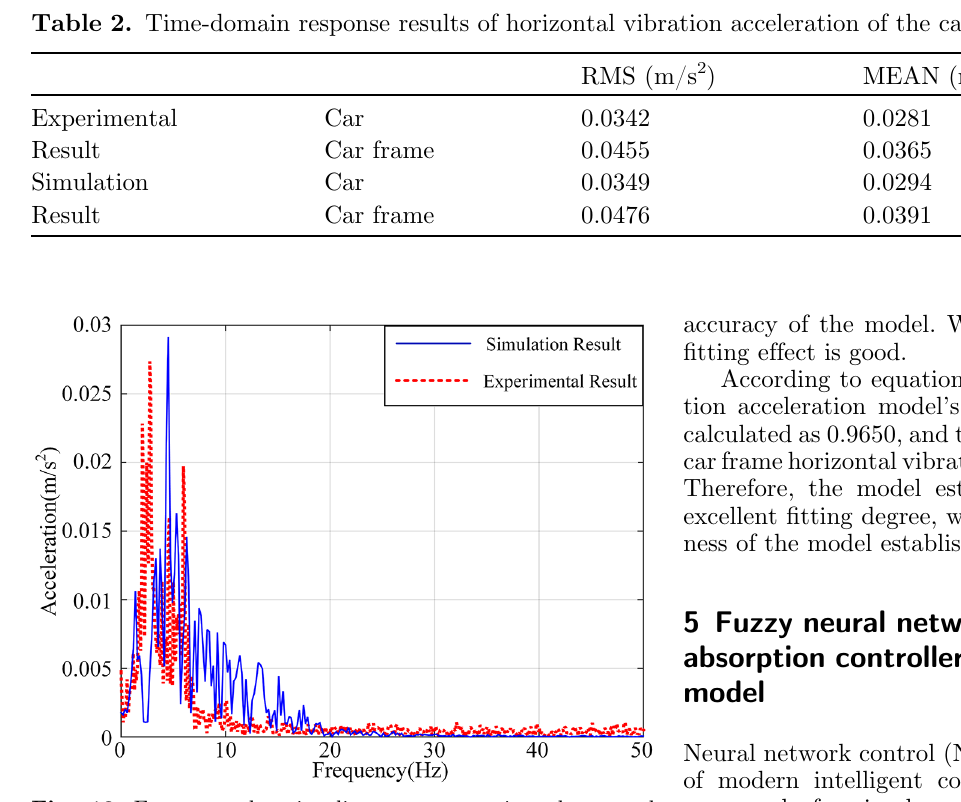
Fig. 13. Frequency-domain diagram contrasting the actual acceleration and the simulated acceleration of the car frame.